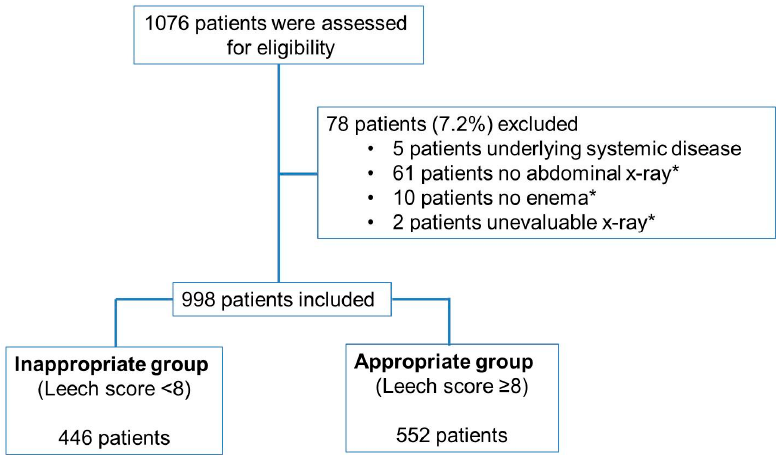
Figure 1. Patient flow chart after application of the inclusion and exclusion criteria. The study selection process after applying the inclusion and exclusion criteria is shown. * no abdominal X- ray: did not undergo abdominal X-ray. * no enema: did not proceed with the enema procedure. * un-evaluable X-ray: no images of the rectosigmoid